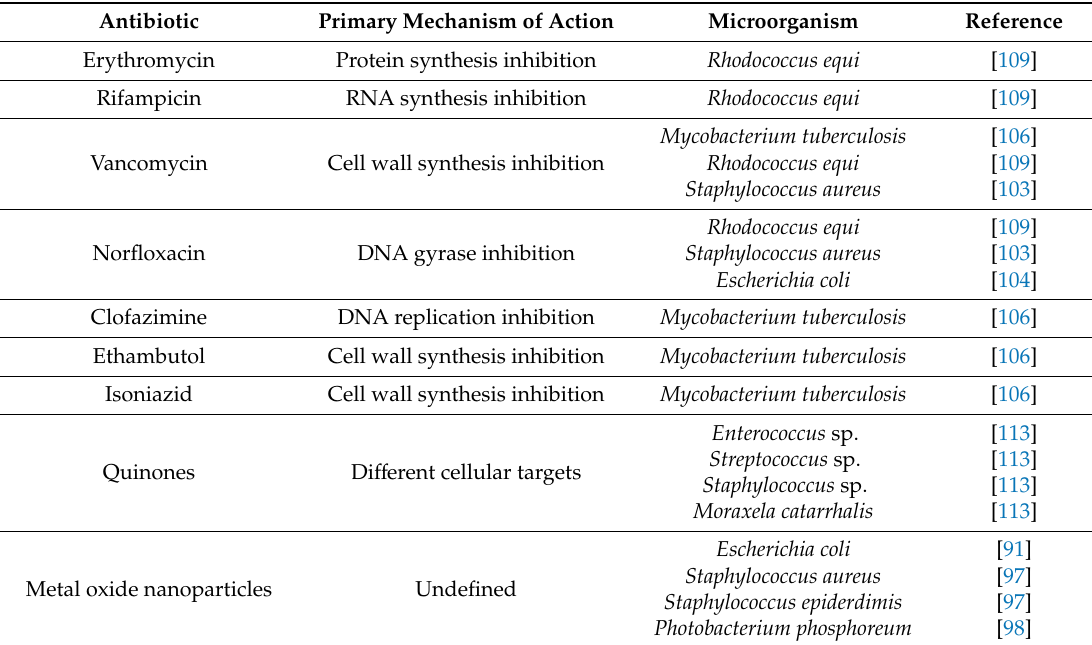
Table1. ListofRONS-generatingantimicrobials, theirprimarymechanismofactionandmicroorganisms on which their ability to produce oxidative stress was